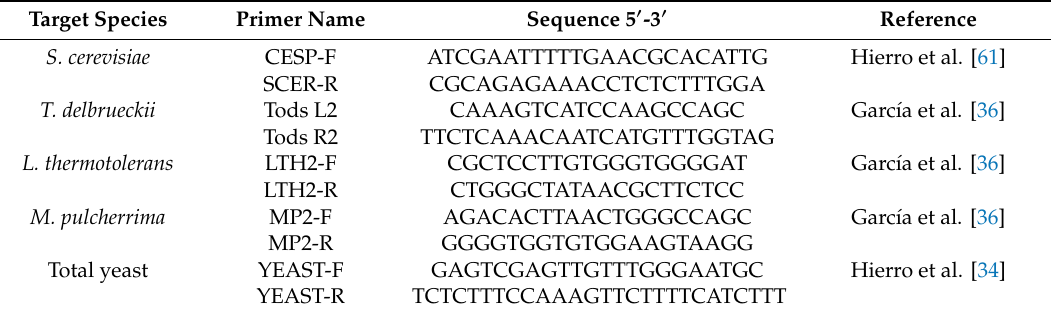
Table A1. Primer sequences used for quantitative PCR analysis.